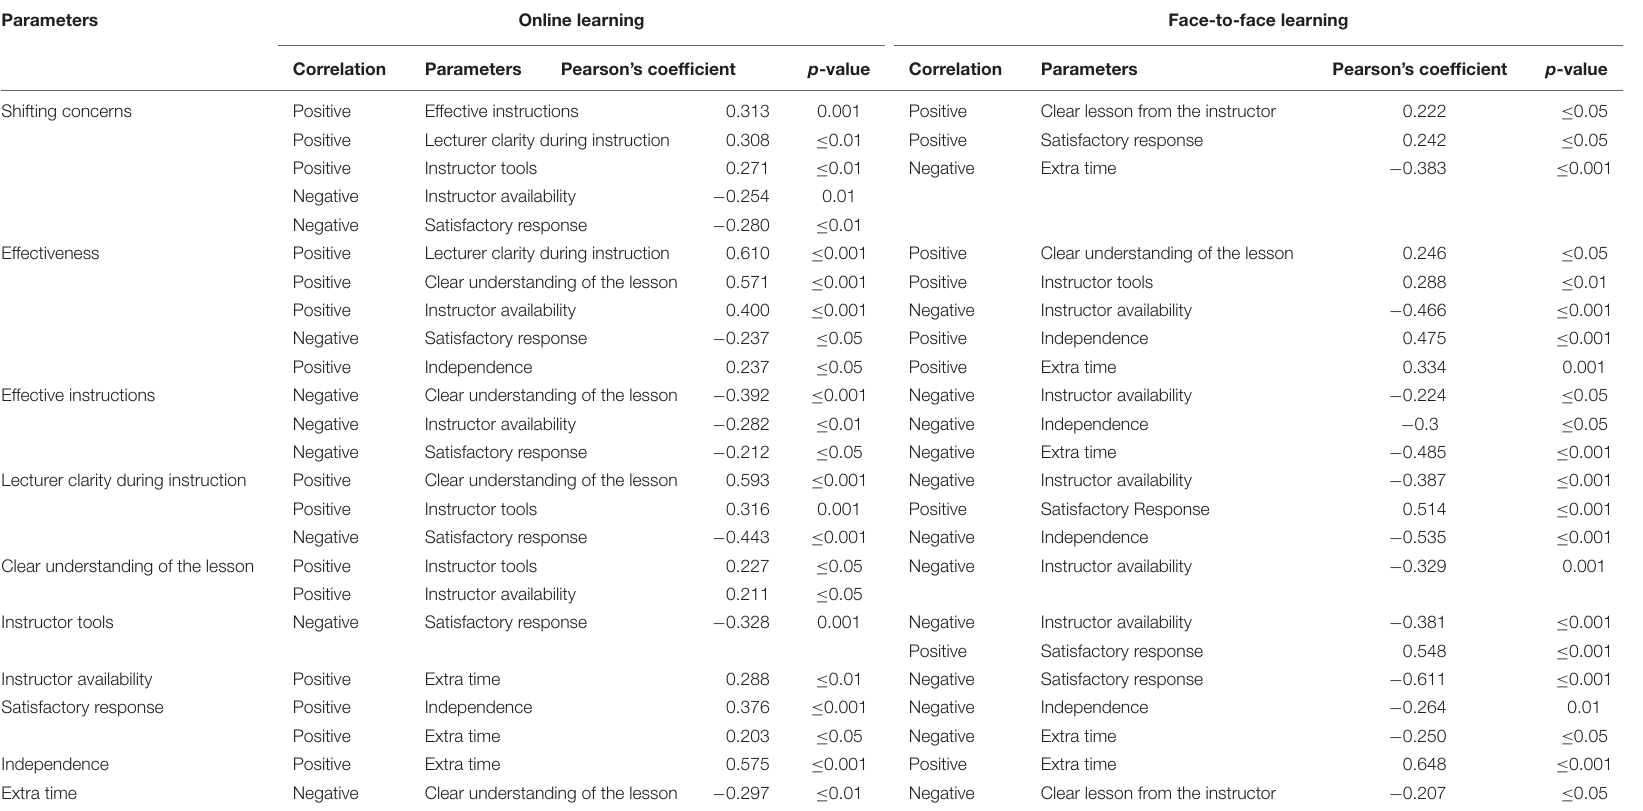
TABLE 6 | Significant correlation of different parameters regarding online learning and face-to-face learning.